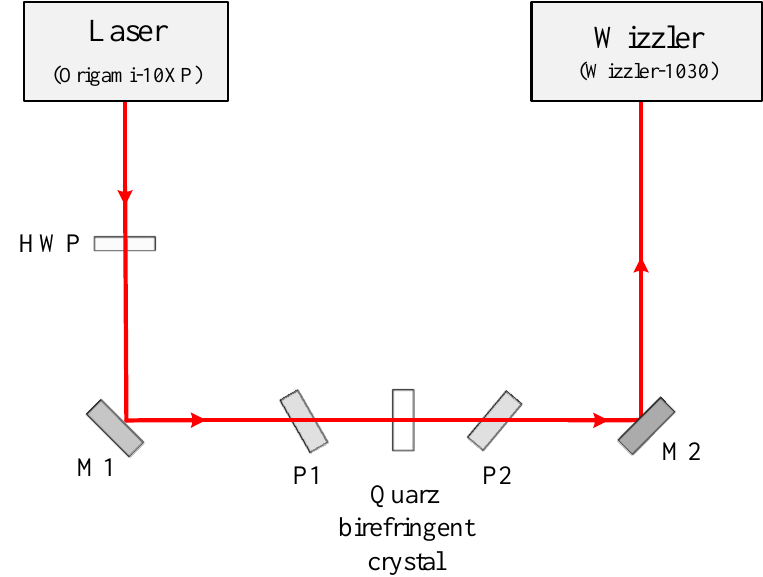
Figure 7. Schematic diagram of principle – proof experiment for dispersion control, which uses a quartz birefringent crystal and measured by Wizzler; HWP is the half waveplate; M1 and M2 are reflector mirrors; P1 and P2 are polarizers.